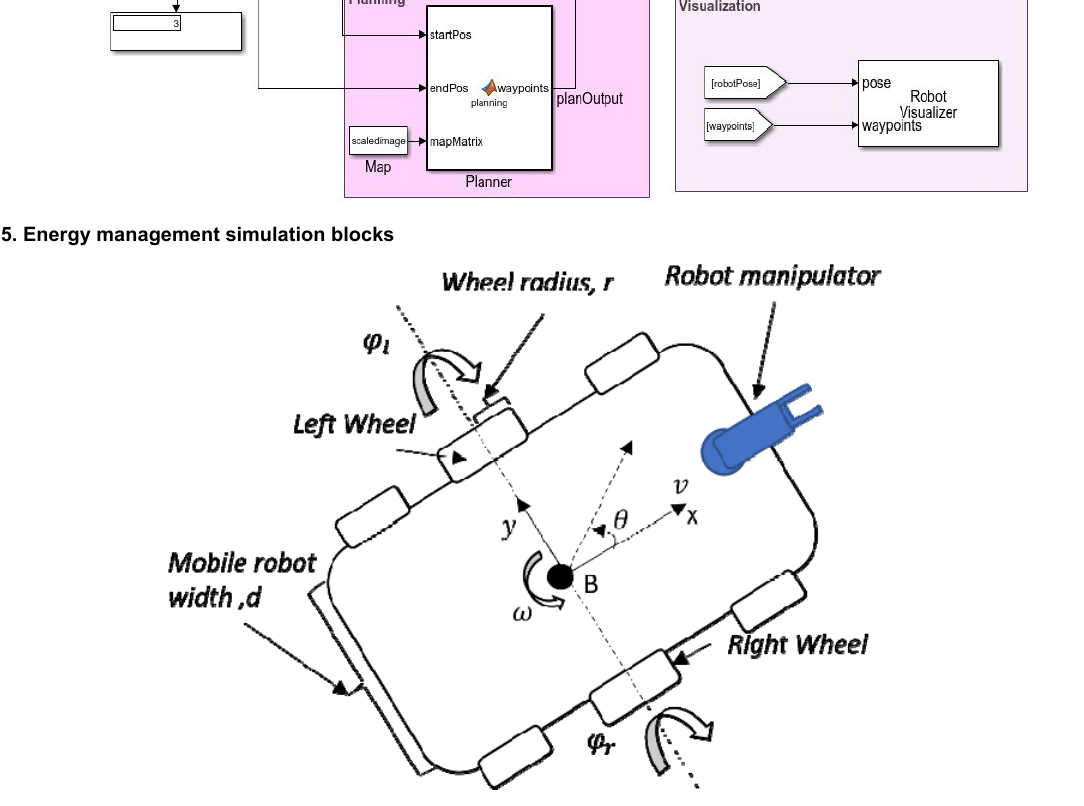
Figure 6. A simplified view of differential drive